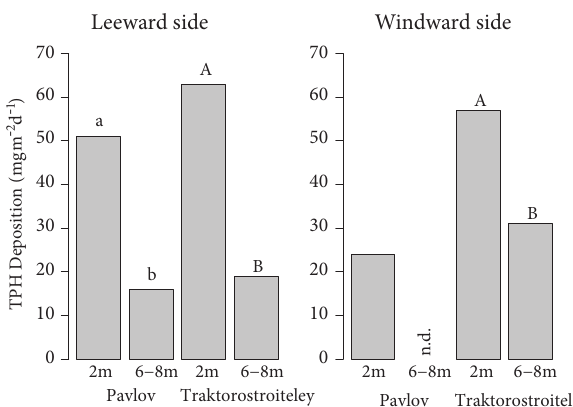
Fig. 2. Depositional flow of total petroleum hydrocarbons on snow. Same letters indicate non-significant ranges (Tukey-test, p = 0.05), n.d. –